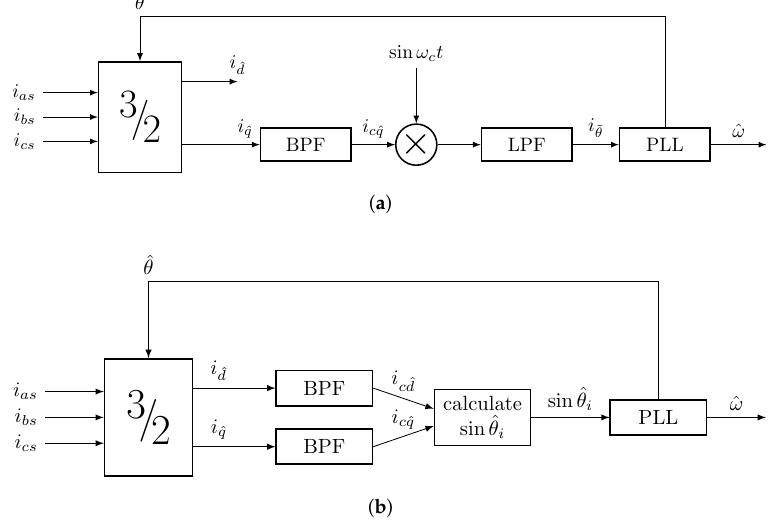
Figure 5. Procedure of signal processing. ( a ) Procedure of signal processing to extract ˜ θ -related information; ( b ) procedure of signal processing to extract ˆ θ i -related information.